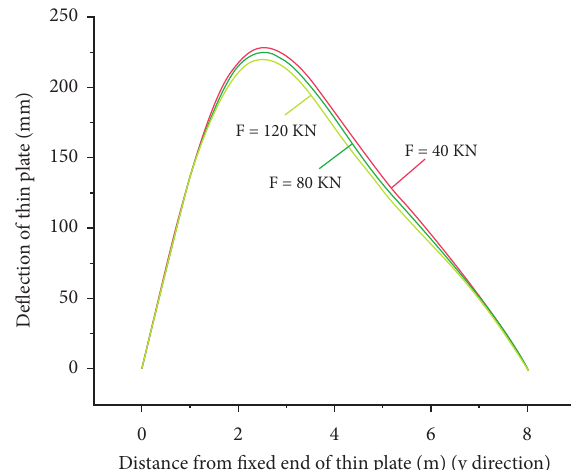
Figure 4: Curves of roof deflection under different supporting forces.